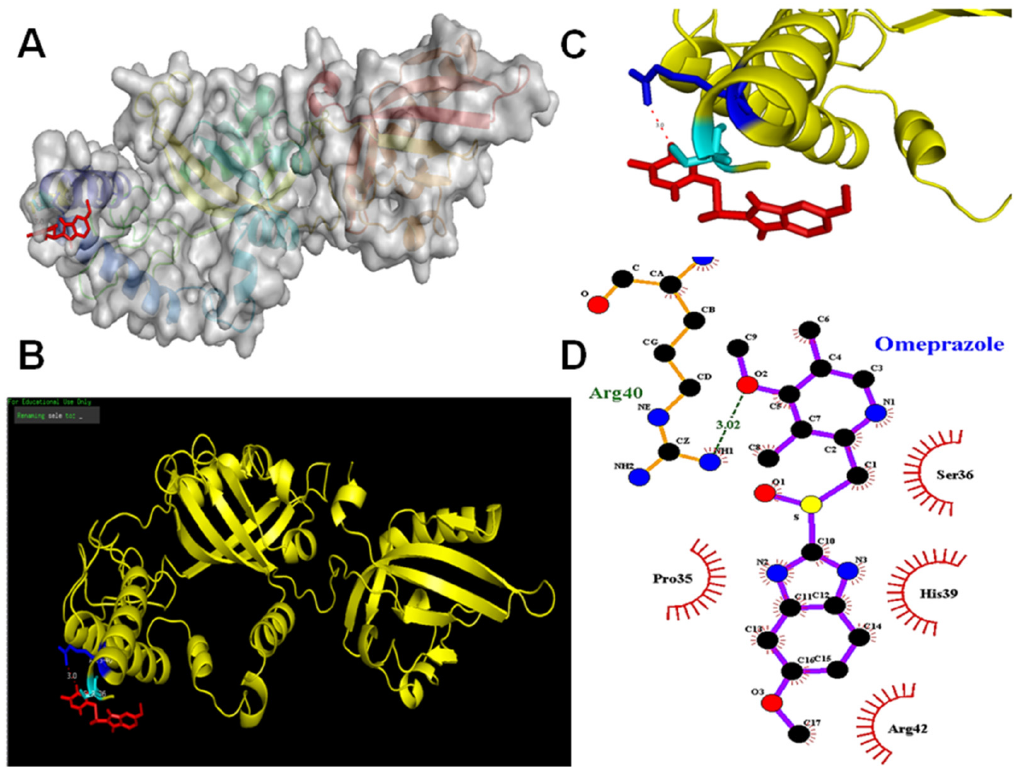
Figure 3. Omeprazole activated the AhR (Ser36) site by a molecular docking simulation. The chemical structure of omeprazole revealed binding modes in the AhR (Ser36) site by virtual screening. General and local overviews of the best interaction after automated docking of binding omeprazole (red) to the active site of AhR are shown. ( A ) Surface representation of the ligand–receptor binding. Omeprazole (red) and AhR are shown in surface representation. ( B ) Local interaction positions of the AhR (Ser36) active site (blue). The cave entrance of the zoom-in binding mode of AhR and omeprazole (red) is shown. ( C ) The molecular structure of human AhR with Ser 36 is depicted as a ribbon diagram, with helices and loops. A molecular surface representation of the binding mode of AhR and omeprazole is shown targeting Ser36 representation. The 3D representation of the interactions of omeprazole binding to the AhR active site was generated by PyMOL. ( D ) LIGPLOT generates schematic diagrams of 2D ligand–protein interaction diagrams. The interactions shown are those mediated by hydrogen bonds and by hydrophobic contacts.